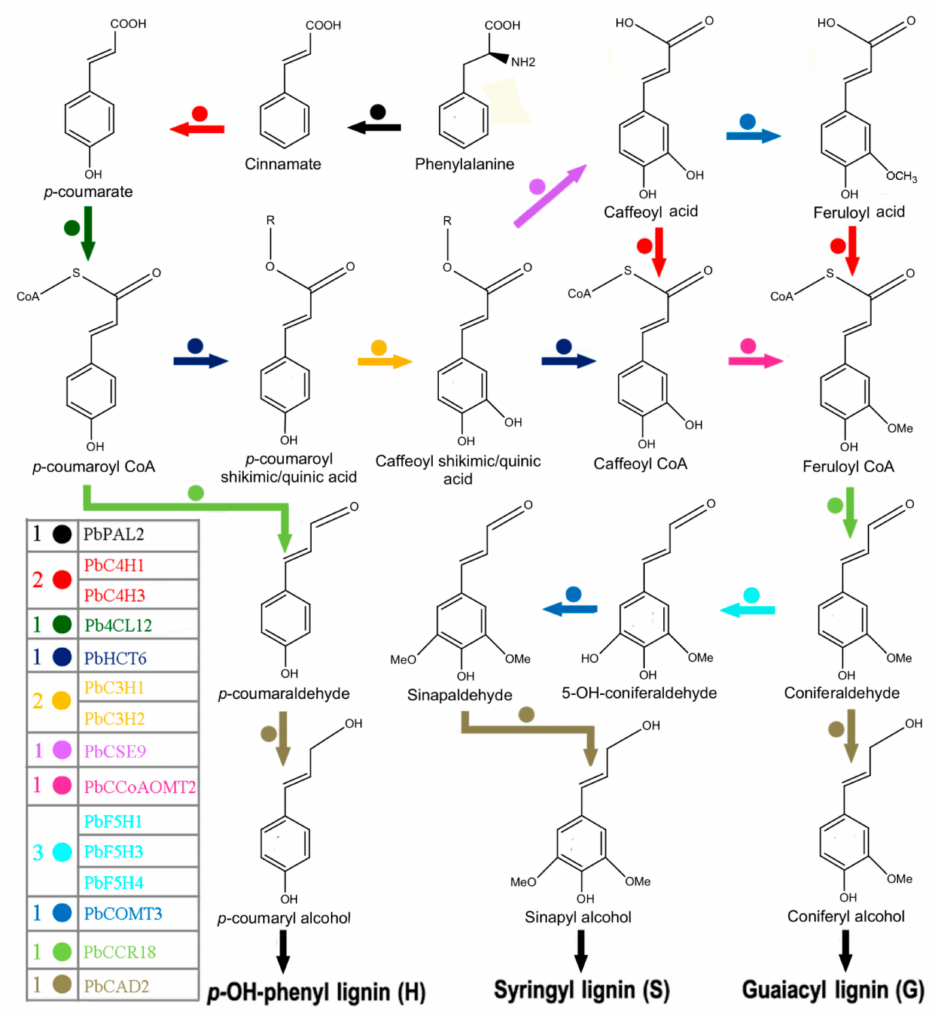
Figure 12. Hypothetical pathways involved in the biosynthesis of lignin in pear fruit. The biosynthetic pathway was adapted from previous findings [3,14,17,72]. The 15 P. bretschneideri genes encoding enzymes located in the bona fide clades constitute the core group of lignin synthesis in pear